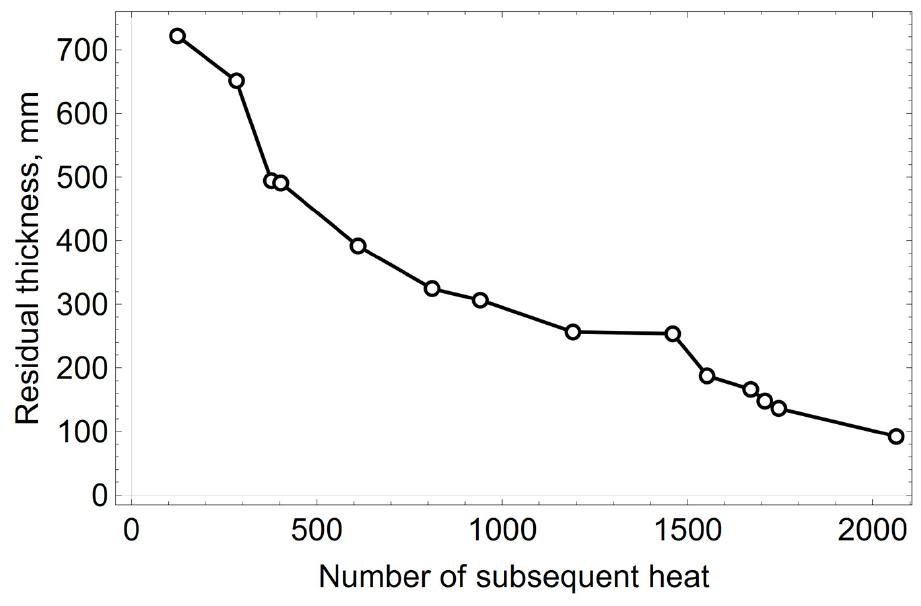
Figure 3. Corrected average residual thickness of the refractory lining of the spout zone.